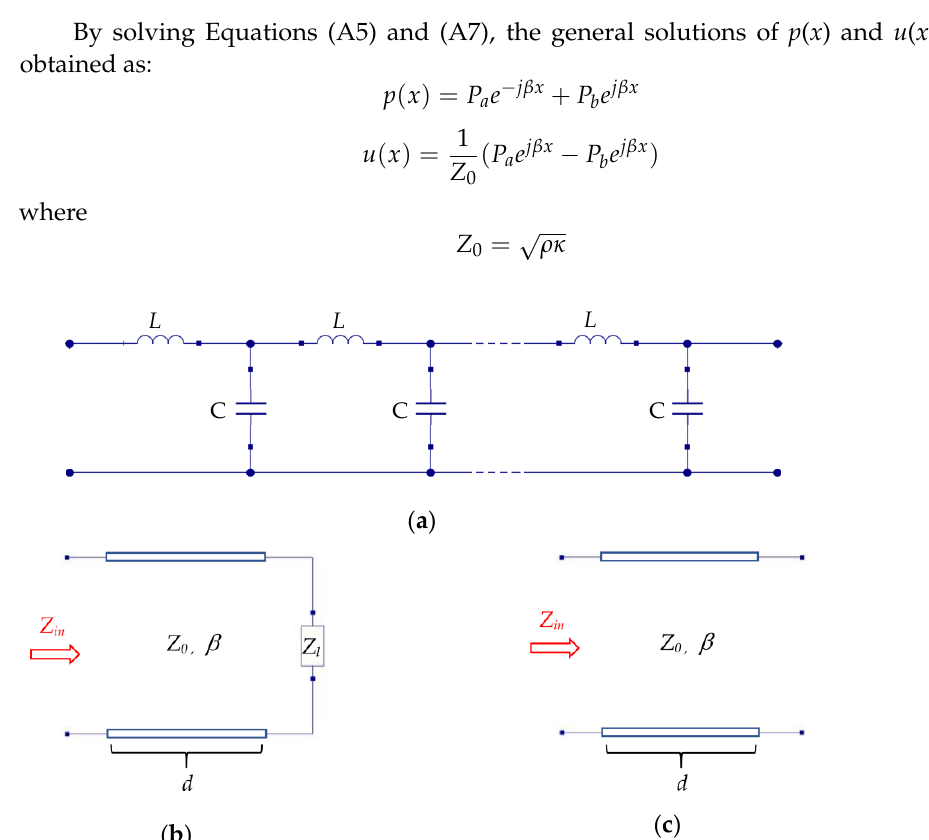
Figure A1. ( a ) Ladder network of a transmission line, composed of series inductors L and shunt capacitors C . ( b ) Z l –terminated transmission line. ( c ) Open–terminated transmission line.